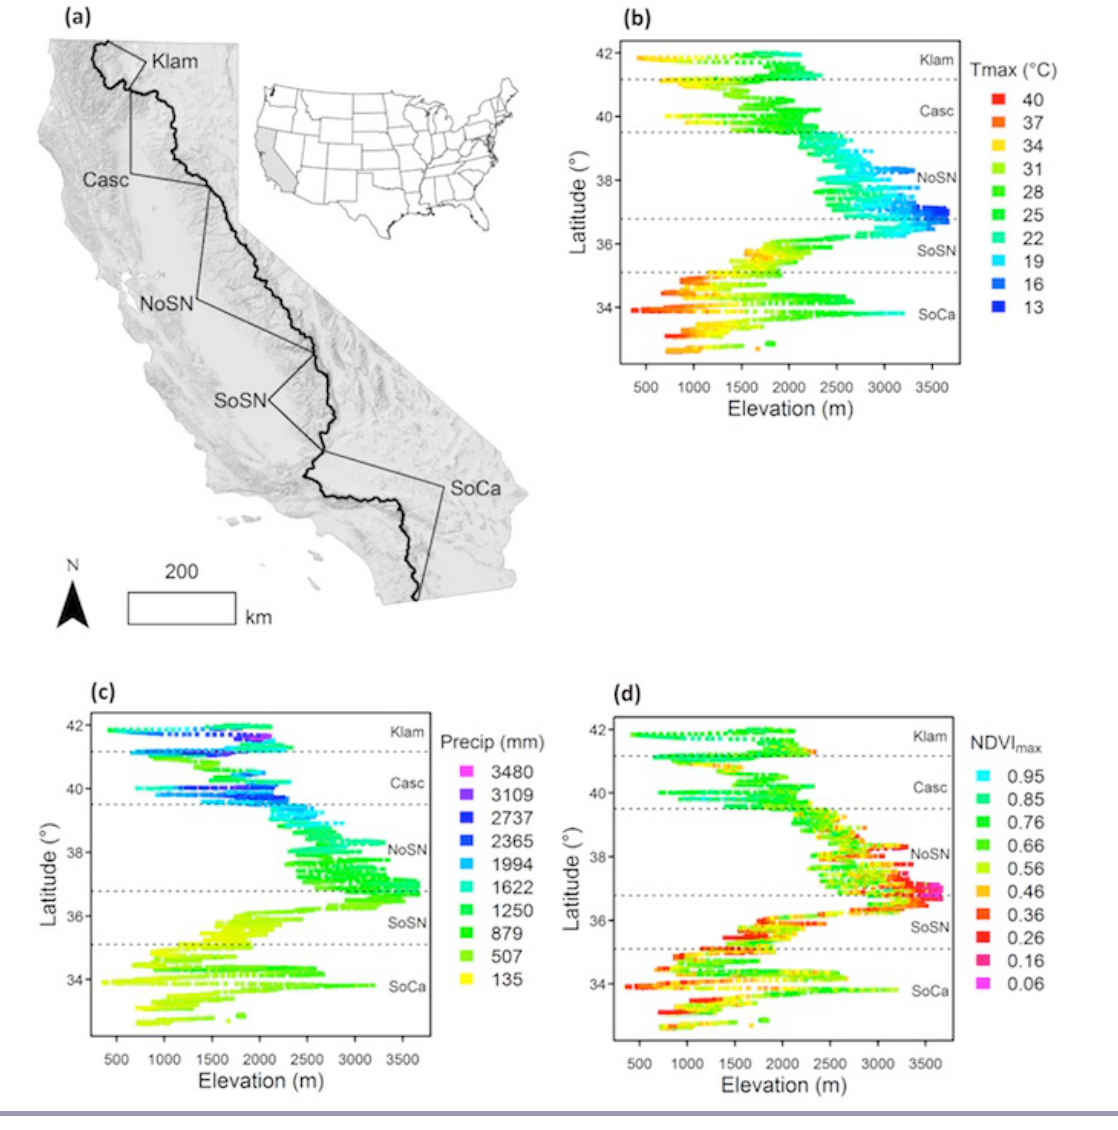
Fig. 1 . Relationships of environmental variables with latitude and elevation across the Pacific-Crest Trail (PCT) within California. (a) Map showing the extent of the mega-transect in California and locations of the five regional sections of the PCT. The black line indicates the route of the PCT. Graphs depict underlying environmental gradients in (b) average maximum annual temperature (Tmax), (c) total annual precipitation (Precip), and (d) maximum seasonal Normalized Difference Vegetation Index (NDVI sites. Dotted lines in graphs indicate latitudinal cutoffs for each region. SoCa: southern California, SoSN: southern Sierra Nevada, NoSN: northern Sierra Nevada, Casc: southern Cascades, and Klam: Klamath